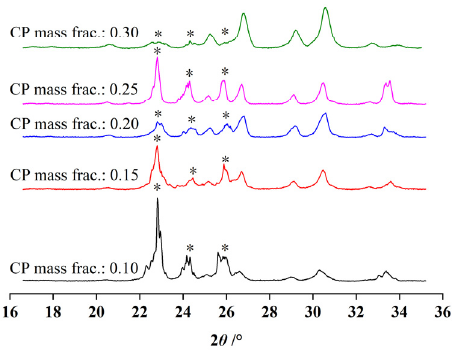
Figure 6. The PXRD patterns of the hydrate samples formed at the liquid phase with different CP mass fraction.